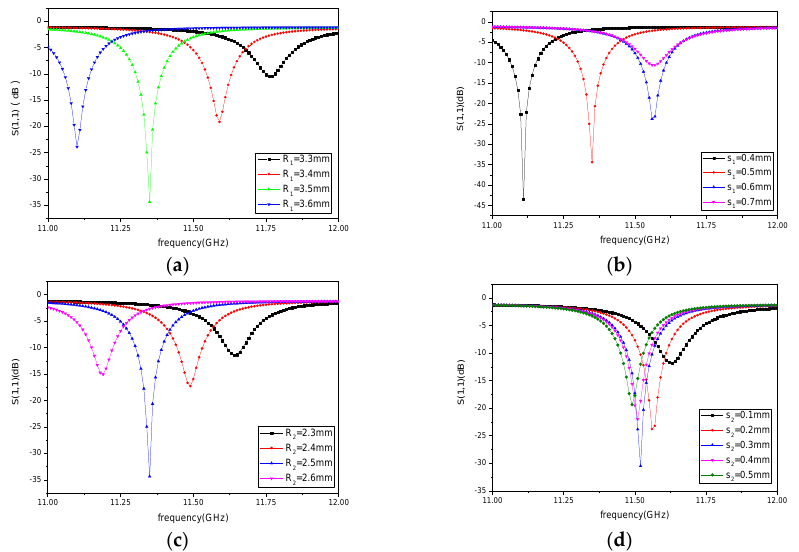
Figure 3. Simulation of complementary split ring resonator (CSRR) Parameter Optimization: ( a ) Radius of CSRR external resonant ring R 1 , ( b ) Gap width of CSRR external resonant ring s 1 , ( c ) Radius of CSRR internal resonant ring R 2 , ( d ) Gap width of CSRR internal resonant ring s 2 . According to the simulation results, the radius of the CSRR external resonant ring R 1 , the width of the gap of the external resonant ring s 1 and the radius of the internal resonant ring R 2 all affect the resonant frequency of the sensor. When R 1 increases, the resonant frequency decreases accordingly. This is because the equivalent capacitance increases